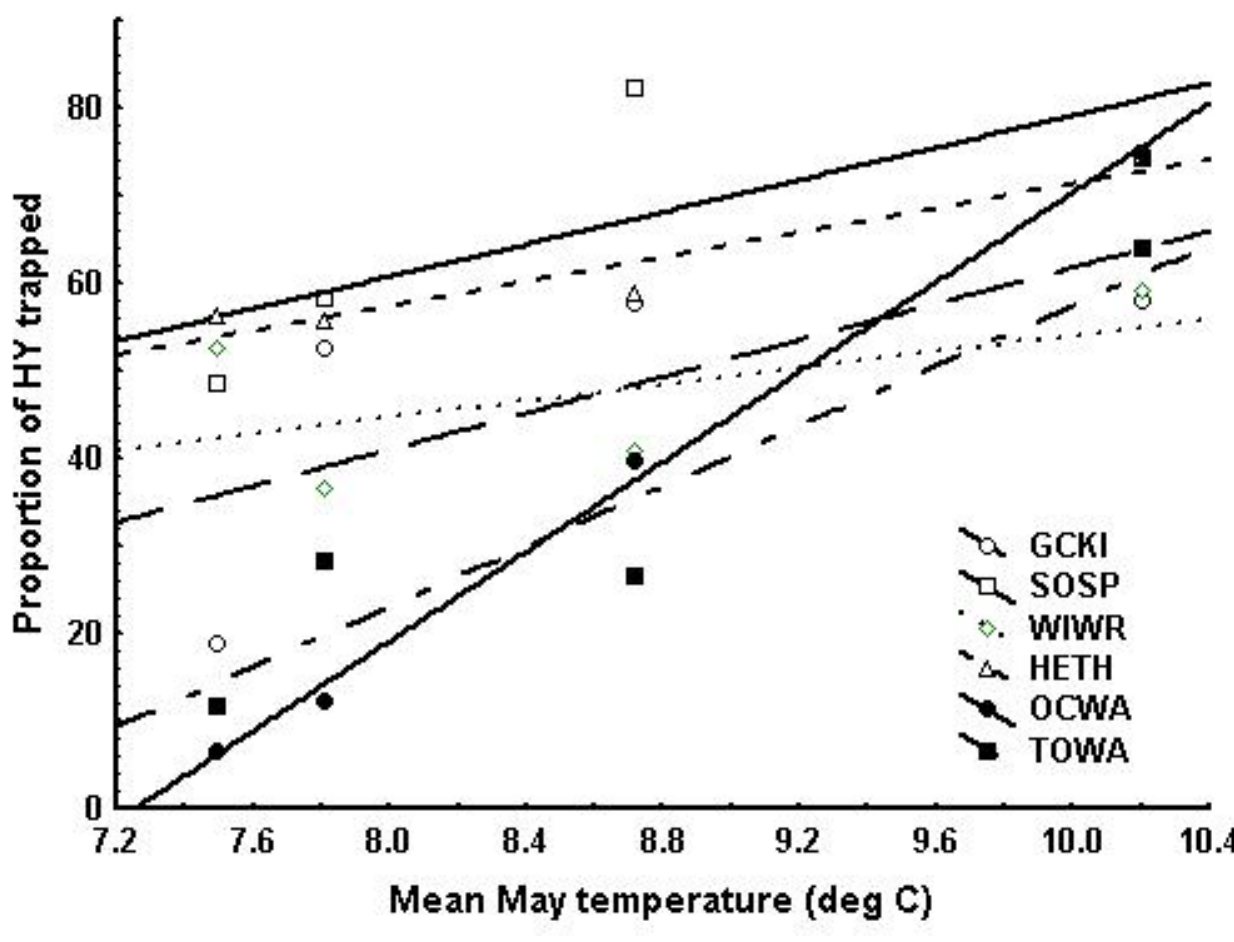
Fig. 5 . Relationship between proportion of hatching-year (HY) birds captured during the core mist-netting period and mean May temperature at Sandspit for six species with adequate samples in all four seasons. GCKI = Golden-crowned Kinglet ( Regulus satrapa ), SOSP = Song Sparrow ( Melospiza melodia ), WIWR = Winter Wren ( Troglodytes troglodytes ), HETH = Hermit Thrush ( Catharus guttatus ), OCWA =